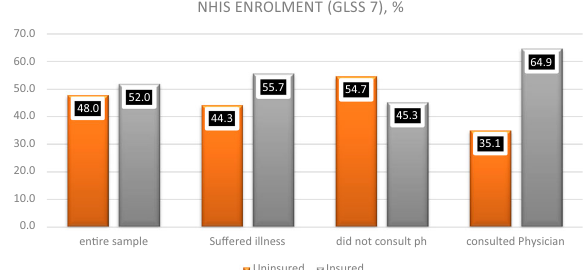
Fig. 2 National Health Insurance Enrollment. This shows the percentage of